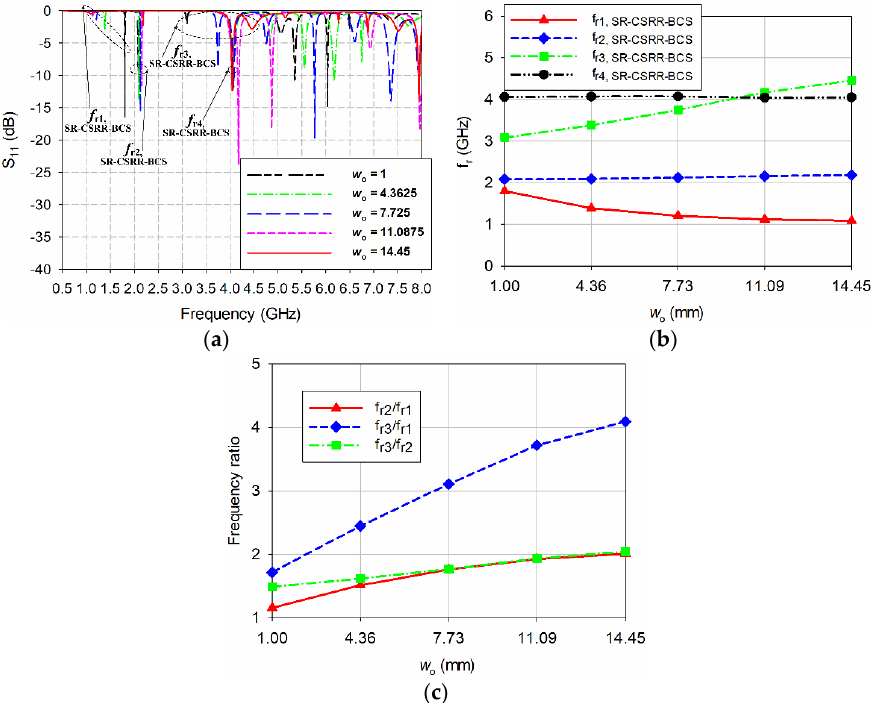
Figure 8. Effect of varying the offset w o of the SR ‐ CSRR ‐ BCS slot from the radiating edge ( w o = 1 mm) toward the patch center ( w o = 14.45 mm) on the resonant frequencies of the SR ‐ CSRR ‐ BCS slot ‐ loaded MPA: ( a ) input reflection coefficient characteristic, ( b ) first four resonant frequencies, and ( c ) frequency ratio between the first three resonant frequencies.